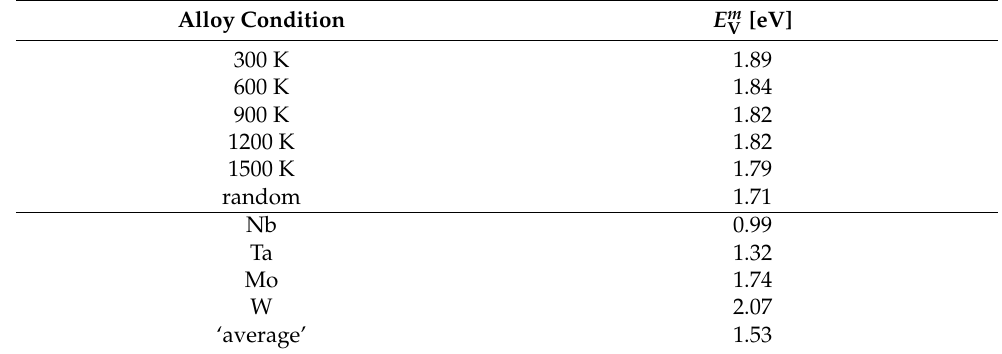
Table 5. Statistical averages of vacancy migration energy distributions of Nb-Mo-Ta-W and vacancy migration energies of the pure constituents. The ’average’ represents the weighted average of vacancy migration energies of Nb, Ta, Mo, and